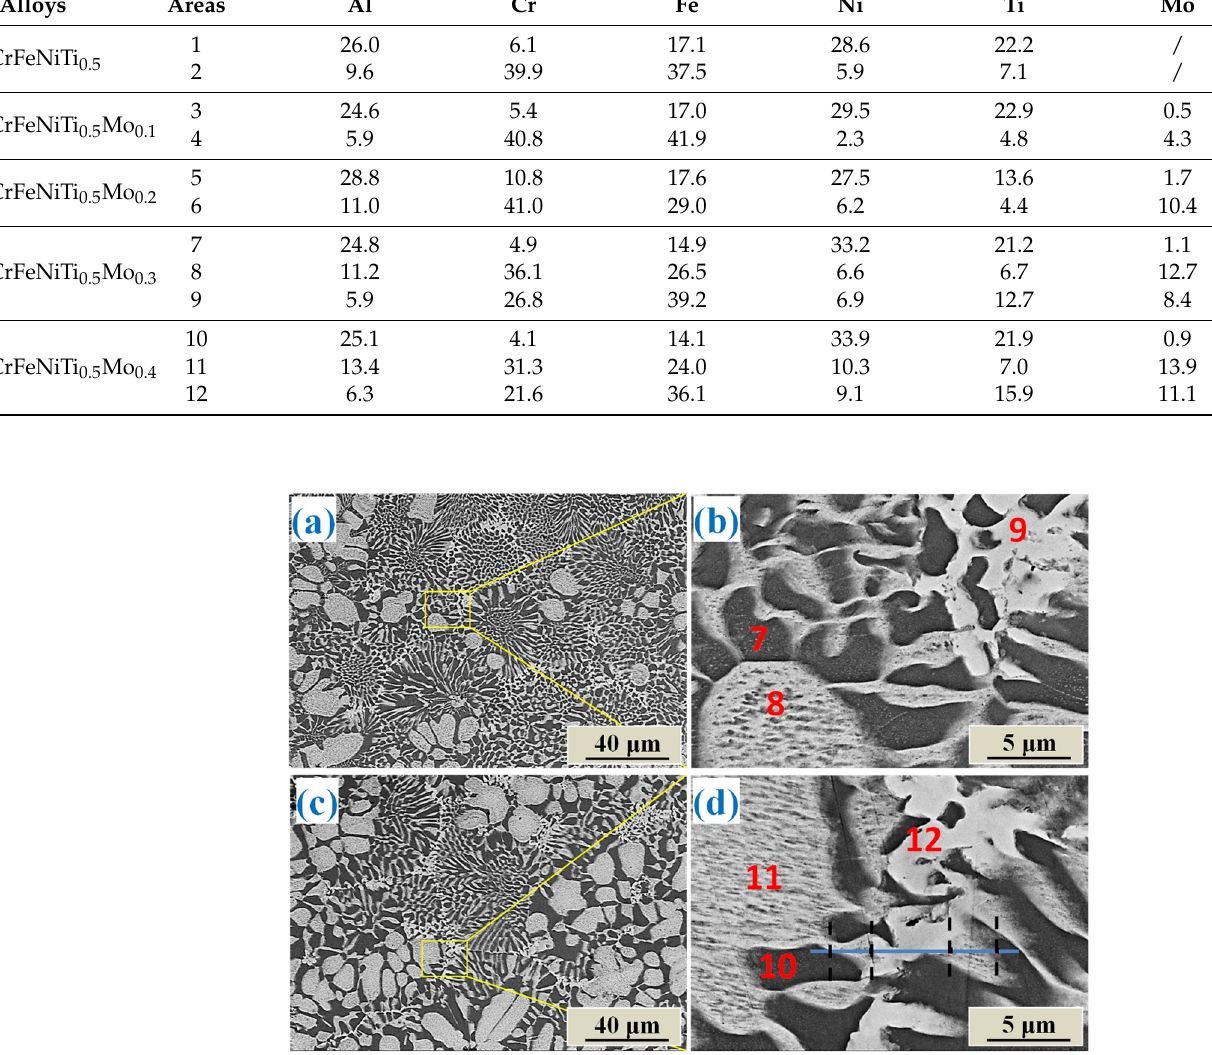
Table 1. Compositions (at. %) of different regions in AlCrFeNiTi 0.5 Mo x alloys. Alloys Areas